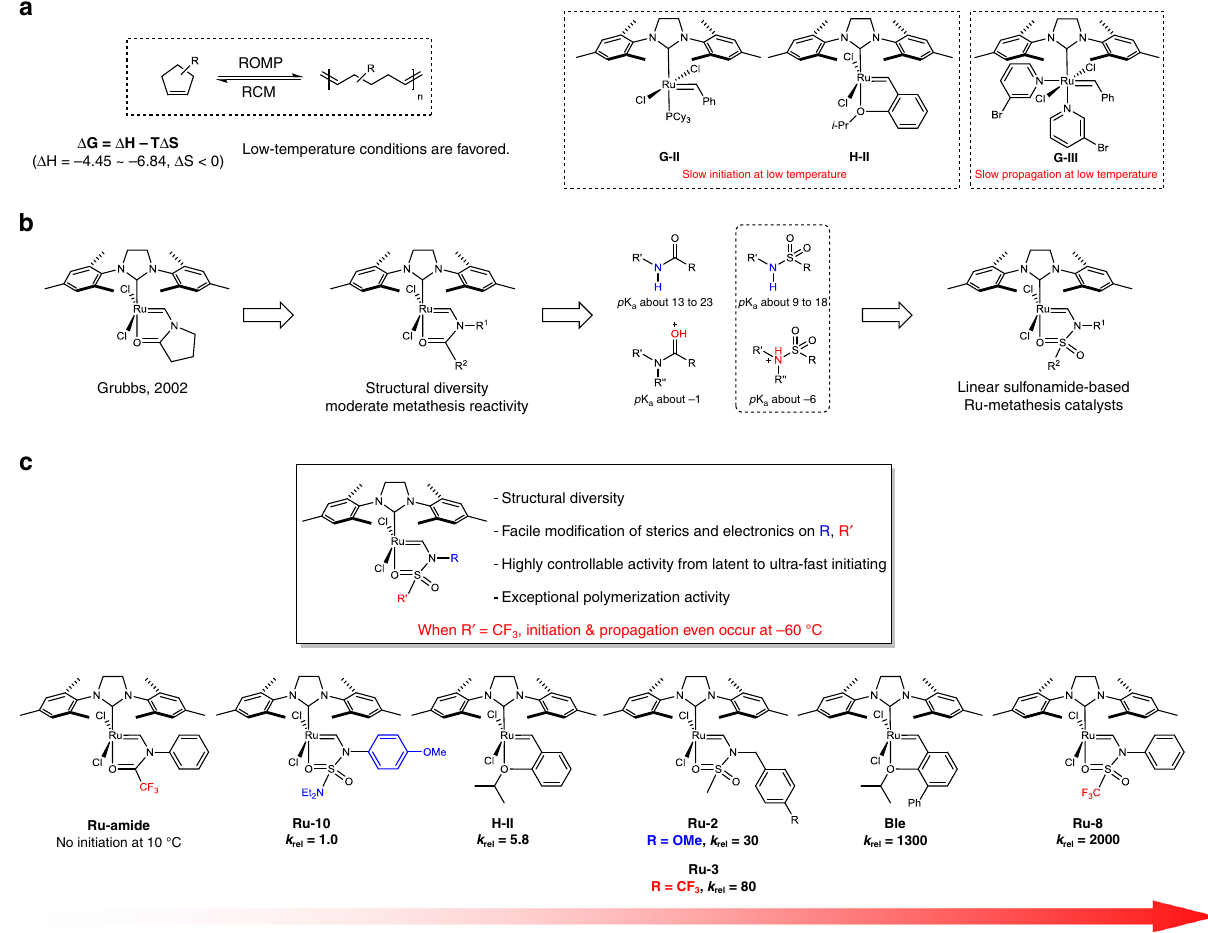
Fig. 1 Development of N -vinylsulfonamide-based ole fi n-metathesis catalysts. a Representative Ru-based ole fi n-metathesis catalysts have limited initiation or propagation properties in ROMP at low temperatures. b The development of N -vinylsulfonamide-based metathesis catalysts. c Comparison of the initiation rates of Ru-based ole fi n-metathesis catalysts. The k init values were determined by reacting a catalyst with 30 equiv. of butyl vinyl ether (BVE) at 10 °C in toluene (0.1